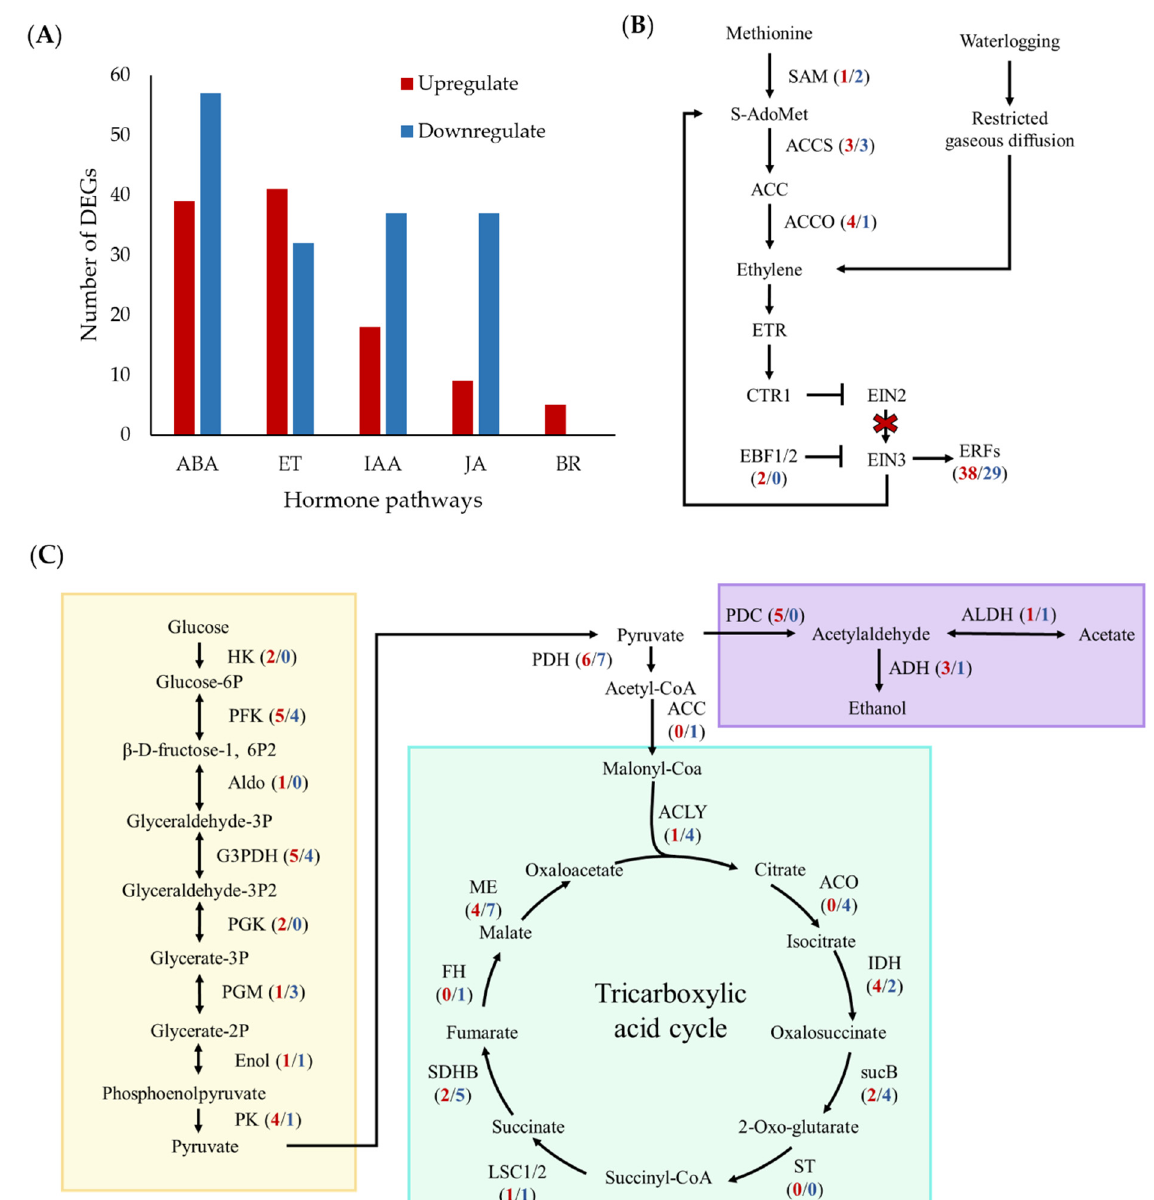
Figure 7. Plant hormone signal transduction pathway after 1 day of waterlogging stress. ( A ) The number of hormone-signal-related DEGs changes in bananas under waterlogging stress. The DEGs were involved in ( B ) the ethylene biosynthetic pathway and ( C ) carbon metabolism. The yellow box highlights the glycolysis pathway, leading to the ethanol fermentation in the purple box, and lastly, the blue box contains genes involved in the TCA cycle. The arrows indicate activation of the gene, while the blunt end represents inhibition of the gene. The red cross indicates the inactivity of the EIN3 pathway that leads to the activation of ERF TFs. The numbers in parentheses correspond to the number of upregulated (red) and down-regulated genes (blue). [ABA, abscisic acid; ACCO, 1- aminocyclopropane-1-carboxylic acid oxidase; ACCS, 1-aminocyclopropane-1-carboxylic acid syn- thase; ACLY, ATP citrate (pro-S)-lyase; ACO, aconitate hydratase; ADH, alcohol dehydrogenase;